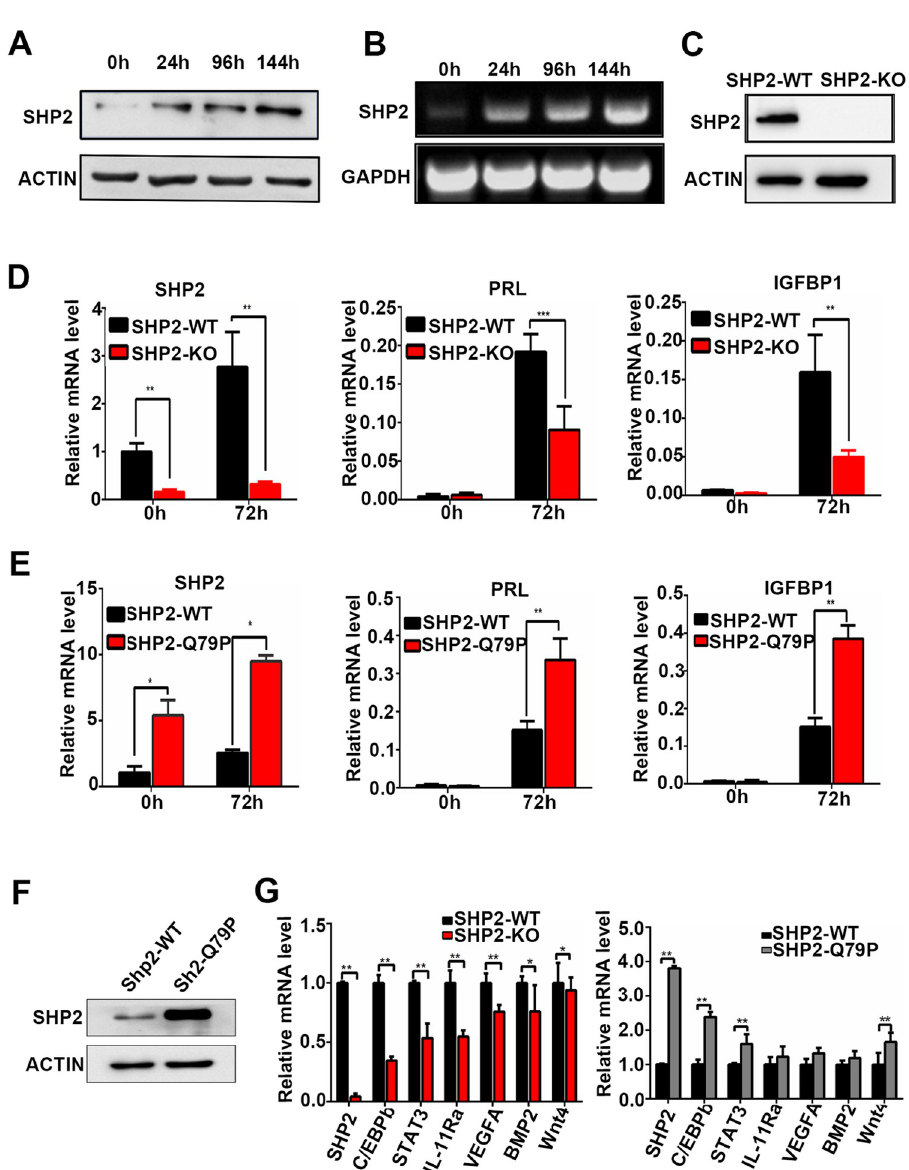
Fig 4. SHP2 is necessary for the decidualization of human endometrial stromal cells. (A) Protein level of SHP2 in human immortalized endometrial stromal cells (hESCs) during decidualization as detected by western blotting. (B) SHP2 mRNA levels in decidualized hESCs as determined by real-time fluorescence quantitative PCR. (C) Protein expression of SHP2 in hESCs with stable knockout as determined by western blotting. (D) The mRNA levels of SHP2, IGFBP1 and PRL in decidual hESCs after knockout of SHP2. (E) The mRNA levels of SHP2, IGFBP1 and PRL in decidual hESCs overexpressing SHP2. (F) Protein expression of SHP2 in hESCs stably overexpressing SHP2 as determined by western blotting. (G) The expression of decidual function genes in hESCs with SHP2 knockout (left figure, SHP2-KO) or SHP2 overexpression (right figure, SHP2-Q79R) as determined by real-time fluorescence quantitative PCR. Actin was used as a total protein control in the western blotting assay. GAPDH was used as an internal reference in RT-PCR. The data are presented as the mean ± SD from at least three independent experiments. Statistical differences are indicated as follows: � P < 0.05, �� P <